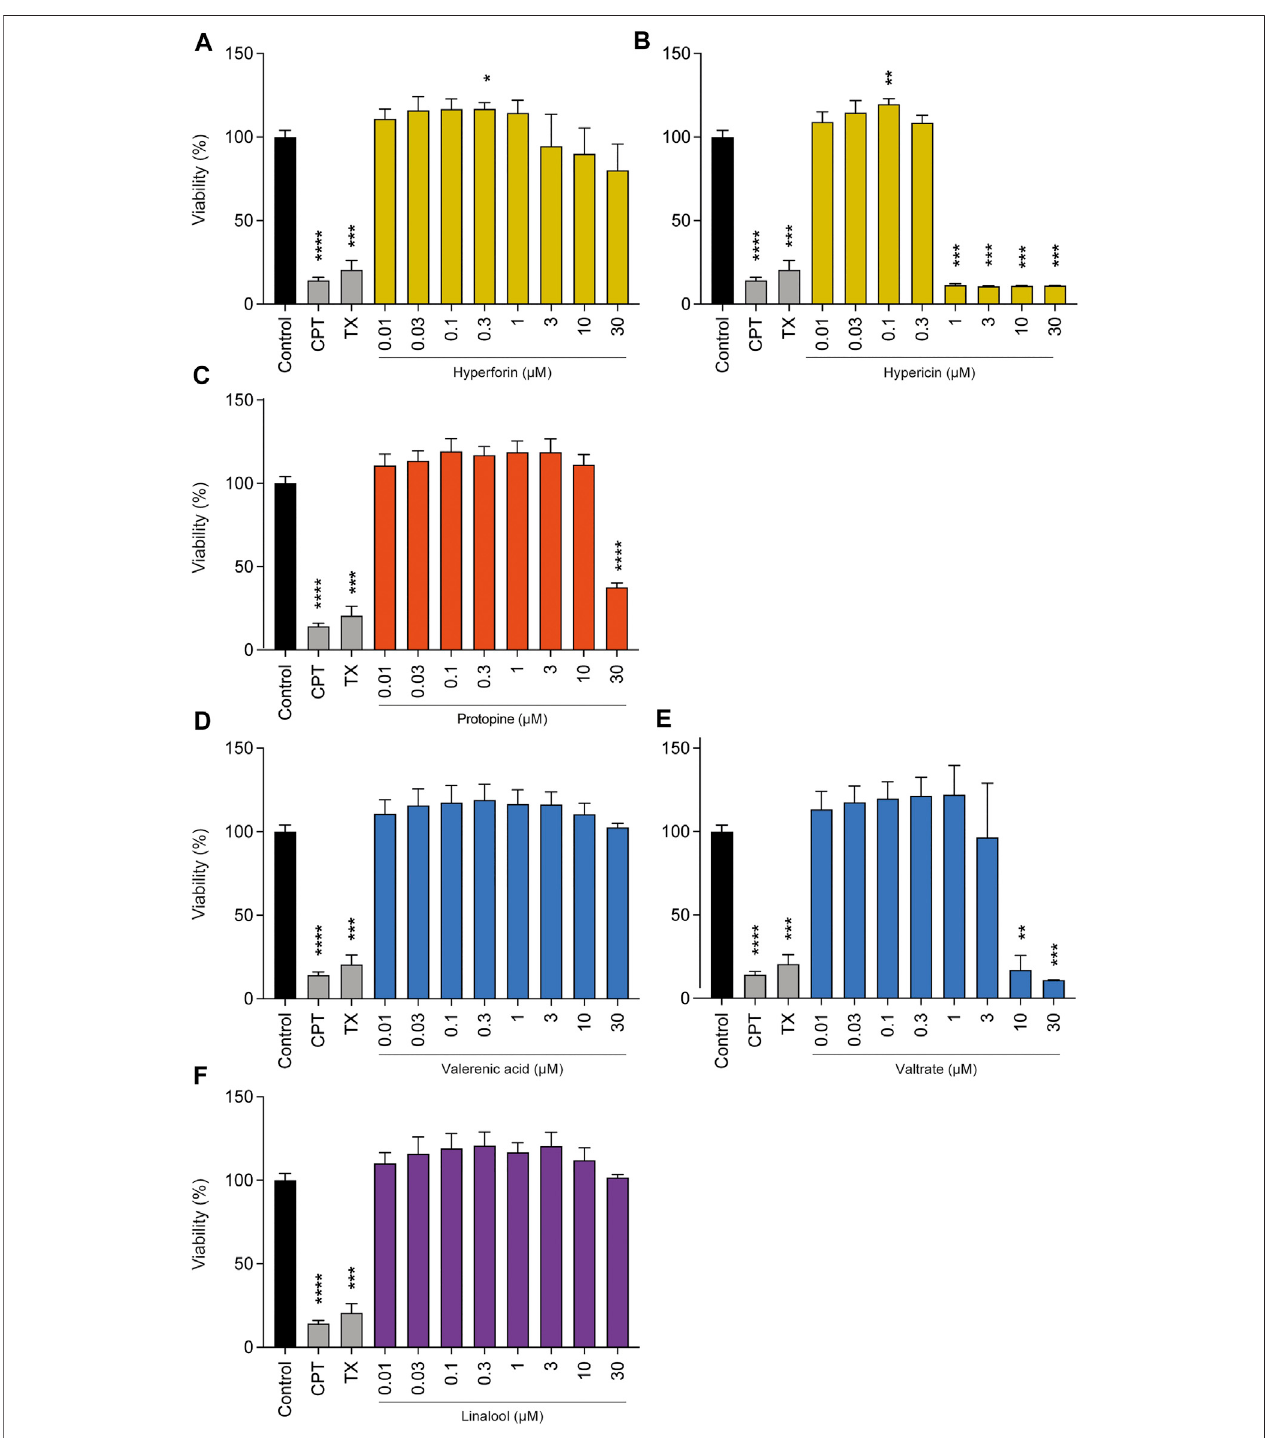
FIGURE 2 | Effects of phytochemicals on cell viability of undifferentiated BeWo b30 cells after 72 h of treatment. Among the phytochemicals present in St. John ’ s wort, such as hyperforin (A) and hypericin (B) , only the latter resulted in a signi fi cant reduction in cell viability at concentrations of 1, 3, 10, and 30 µM. Protopine (C) (presentinCaliforniapoppy)reducedcellviabilityby62.4%ataconcentrationof30 µM.Ofthephytochemicalspresentinvalerian,suchasvalerenicacid (D) andvaltrate (E) , only the latter resulted in a signi fi cant reduction in cell viability at concentrations of 10 and 30 µM. Linalool (F) (ingredient of lavender oil) did not show any signi fi cant effect in a concentration range from 0.01 up to 30 µM. The effects are shown as fold change compared to the untreated control. Treatments with camptothecin (CPT, 300 µM) and Triton-X-100 (TX, 0.5%) served as toxicity controls. Results were normalized to untreated control signal = 100% ( n = 3).